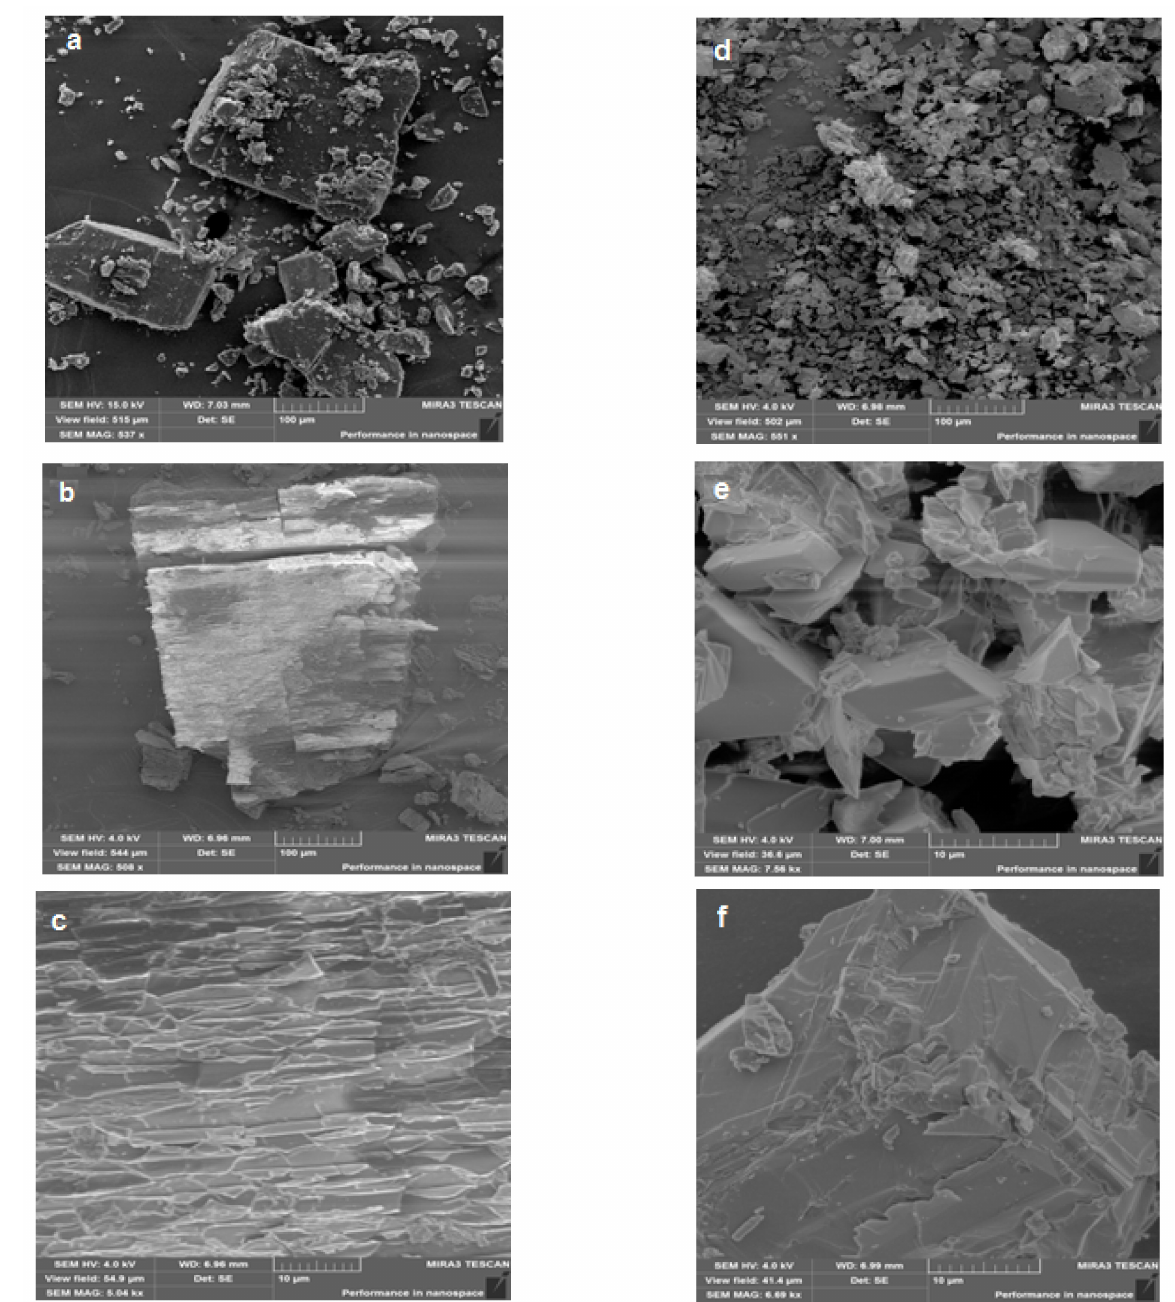
Figure 13. Scanned electron micrographs of β -CD ( a – c ) and the anabasine- β CD (1:1) inclusion complex ( d – f ) at various magnifications (Tescon Mira3